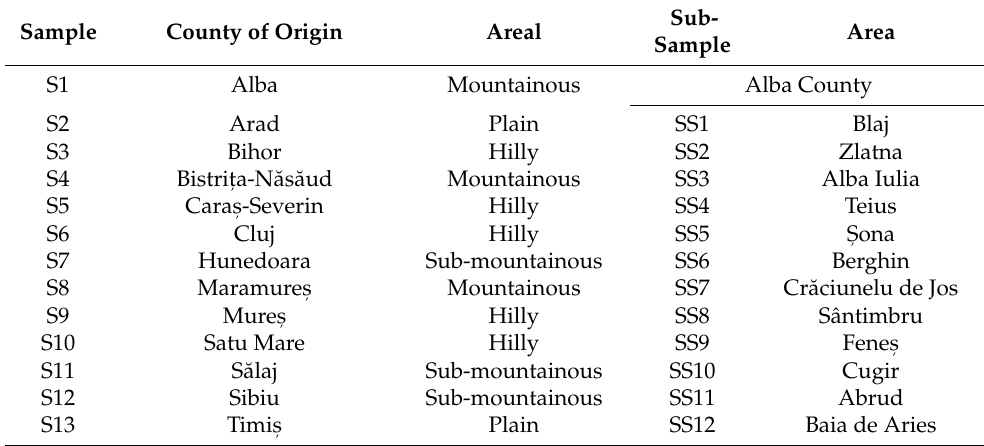
Table 14. The origin of the honey and propolis